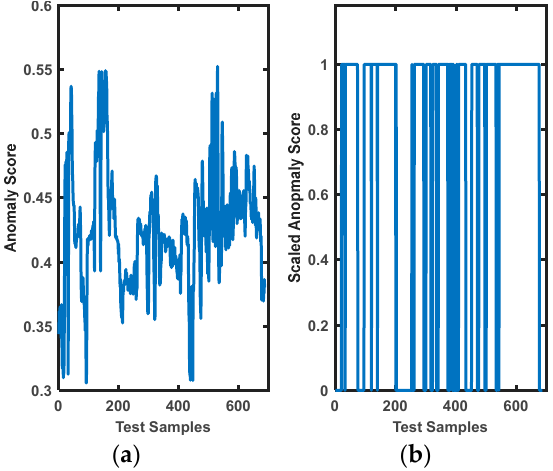
Figure 6. Anomaly scores of test data (rep 3) via iForest algorithm: ( a ) anomaly scores generated by the trained model, ( b ) scaled scores (scores > 0.45 were considered as novel) detecting unsafe interactions. Table 6. Abnormality detection and reaction time via iForest algorithm (test data: rep 3). Abnormal pHRI Test Data Novelty Detection: Elapsed Time Total test data: 686 × 16 samples Accuracy in classifying anomaly = 72% Detected as novel: 189 × 16 samples